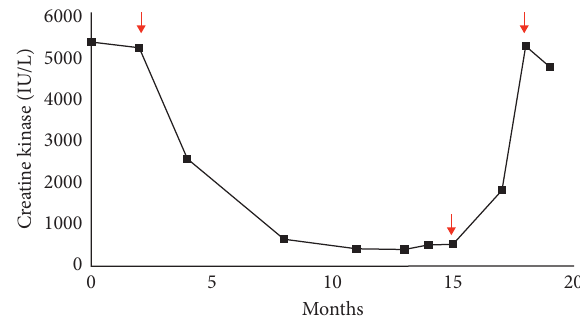
Figure 1: Trends in serum creatine kinase (IU/L) from IMNM diagnosis through his course of COVID-19. First arrow: initiation of concomitant IVIG and mycophenolate mofetil. Second arrow (15 month): the patient’s immunotherapies were held, resulting in a rapid return of creatine kinase to levels greater than 5000IU/L. Third arrow: the patient restarted IVIG and mycophenolate